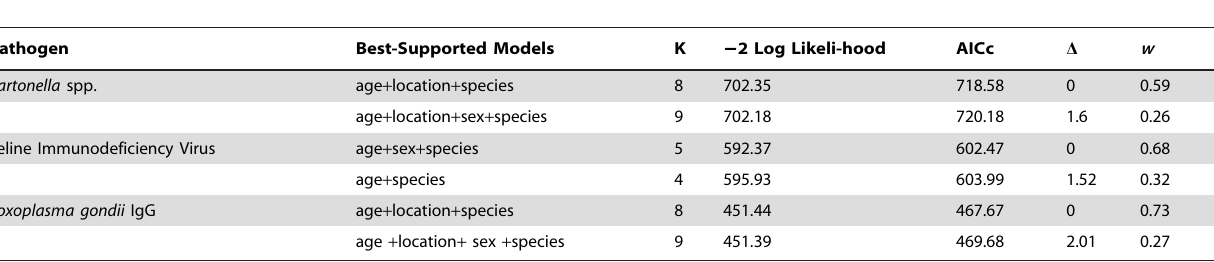
Table 2. Best supported models ( D AICc , 2) of seroprevalence for the three pathogens.